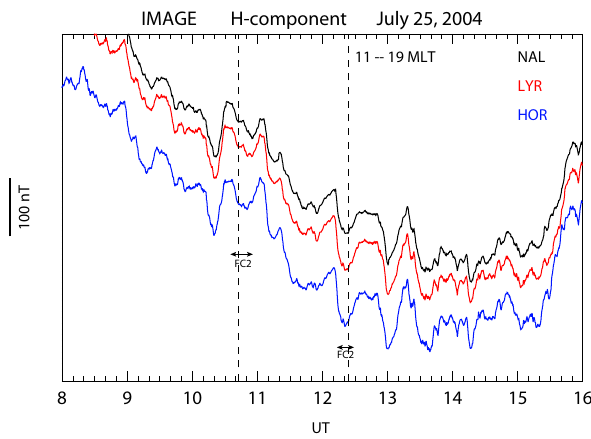
Fig. 7. H-component magnetic deflections from the Image Sval- bard chain of stations Ny ˚Alesund (NAL; 76 ◦ MLAT; black trace), Longyearbyen (LYR; 75 ◦ MLAT; red), and Hornsund (HOR; 74 ◦ MLAT; blue) for the interval 08:00–16:00UT when the stations swept through the 11:00–19:00MLT sector. Vertical guidelines at